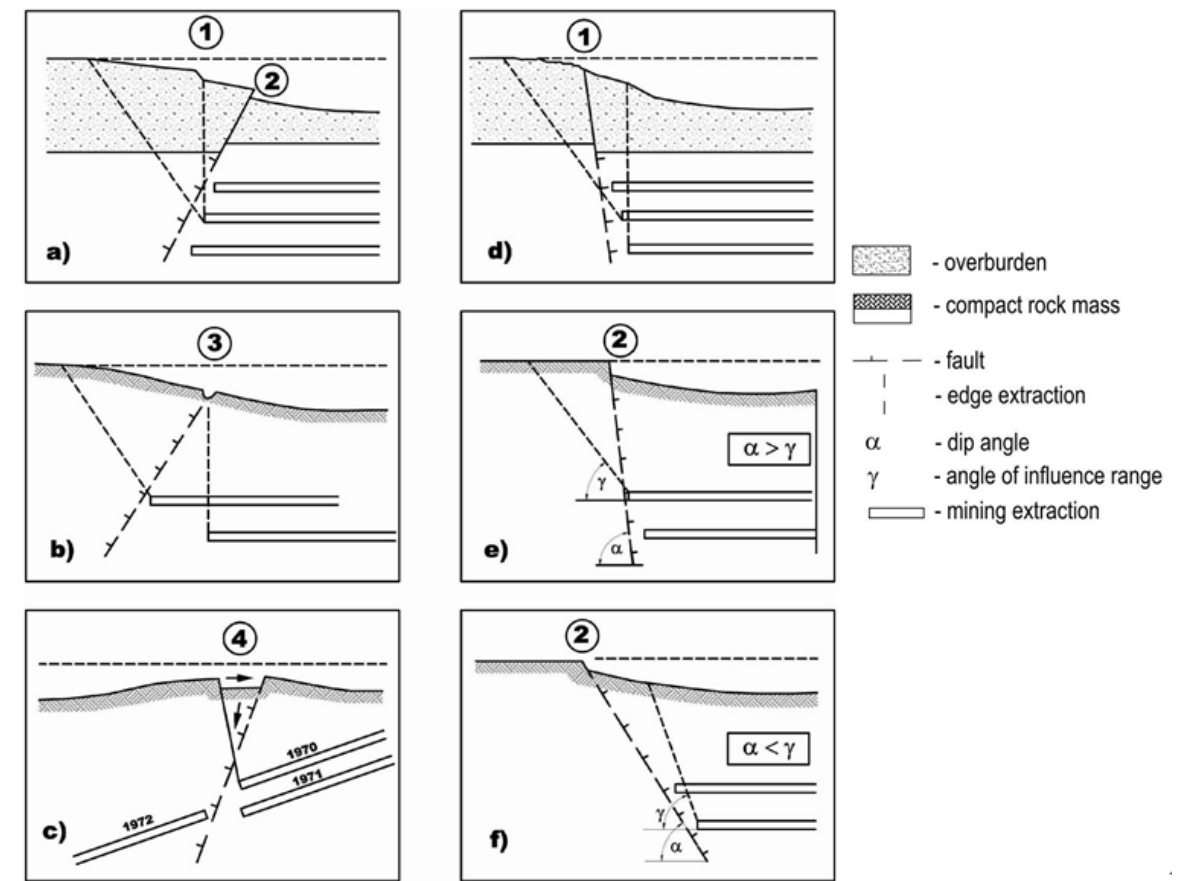
Figure 7. Anomalies of subsidence trough profiles due to fault activation: “( a )” 1—flexures or system of minor steps; 2—ground step; “( b )” 3—fissures; “( c )” 4—graben; “( d )” 1—flexures or system of minor steps; “( e )” 2—ground step α > γ ; “( f ) 2—ground step α < γ . Adapted from [1].